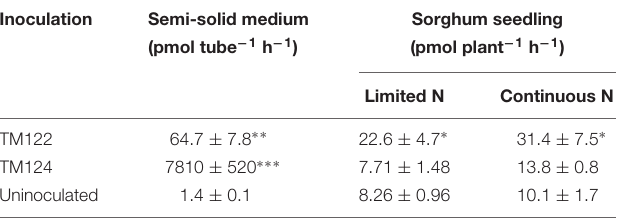
TABLE 5 | Acetylene-reducing activity (ARA) of free-living cells of Bradyrhizobium sp. TM122 and TM124 in semi-solid medium and sorghum seedlings inoculated with TM122 and